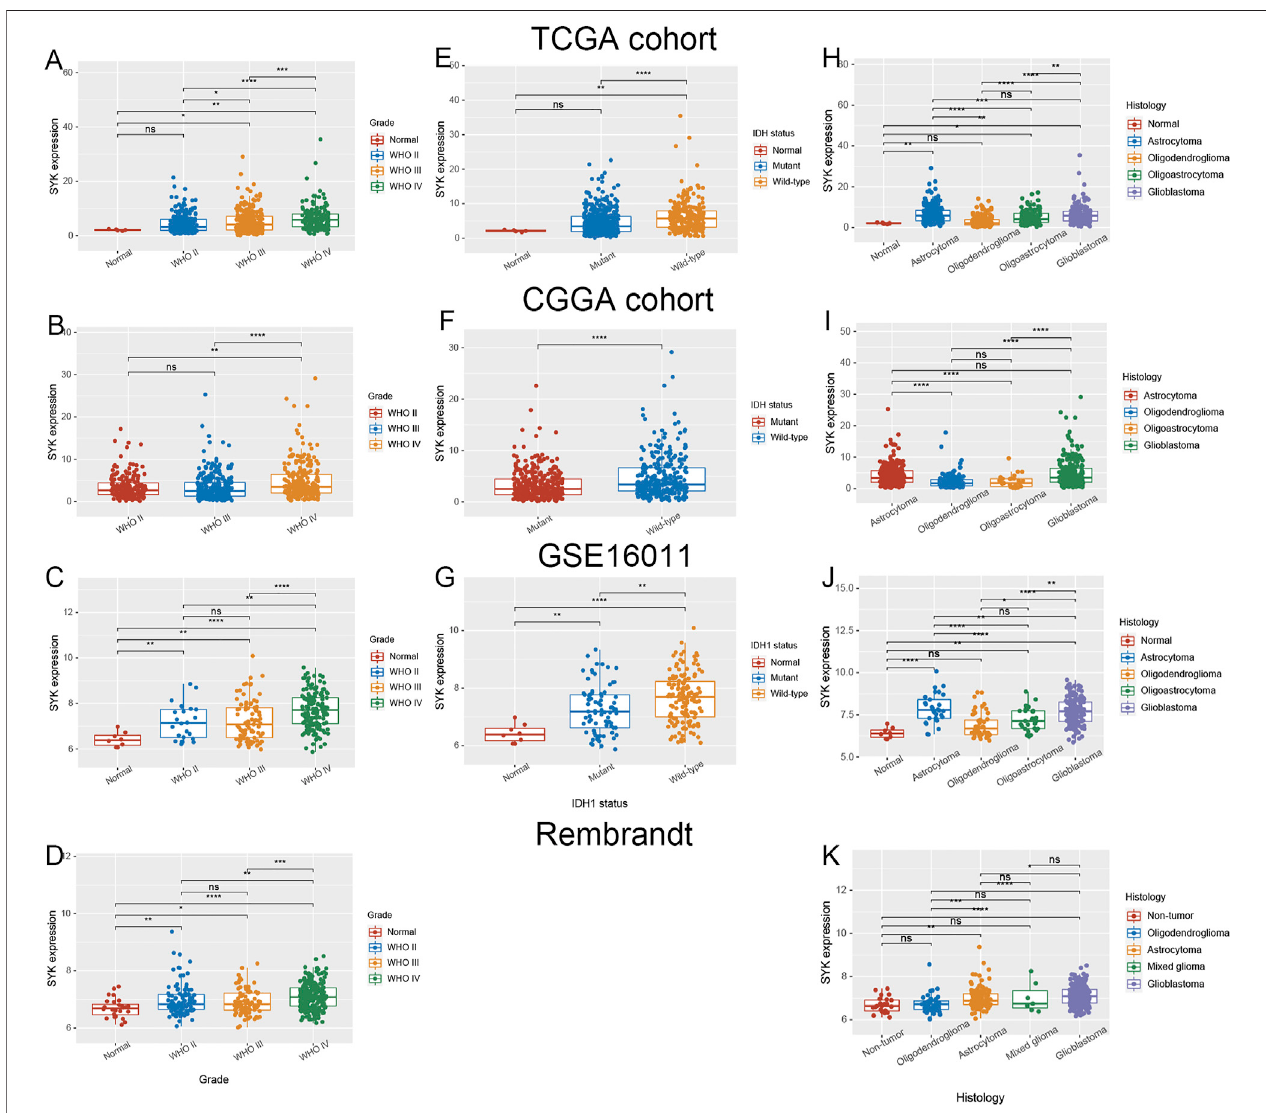
FIGURE 1 | Expression pattern of SYK in diffuse gliomas. (A – D) The expression level of SYK in diffuse glioma with different WHO grades in the TCGA cohort (A) , CGGA cohort (B) , GSE16011 (C) , and Rembrandt cohort (D) ; (E – G) The expression level of SYK in diffuse glioma with wild-type and mutant IDH or IDH1 in the TCGA cohort (E) , CGGA cohort (F) , and GSE16011 (G) ; (H – K) The expression level ofSYK in diffuse glioma with different histologies in the TCGA cohort (H) , CGGAcohort (I) , GSE16011 (J) , and Rembrandt cohort (K) . p < 0.05 was considered signi fi cant.